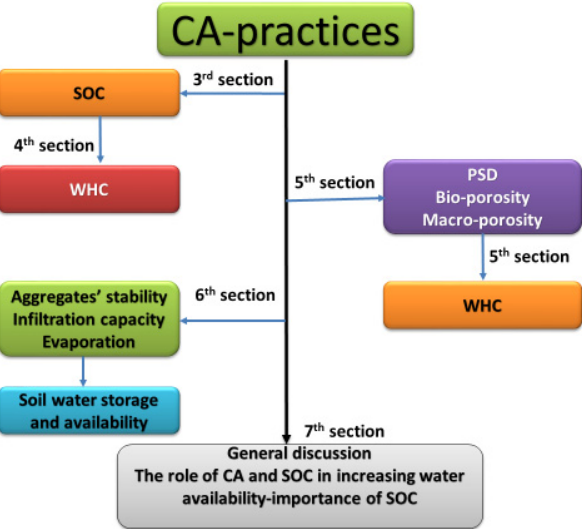
Figure 2. Schematic diagram of the review structure. Where SOC, WHC, and PSD refer to soil organic carbon, water holding capacity, and pore size distribution, respectively.